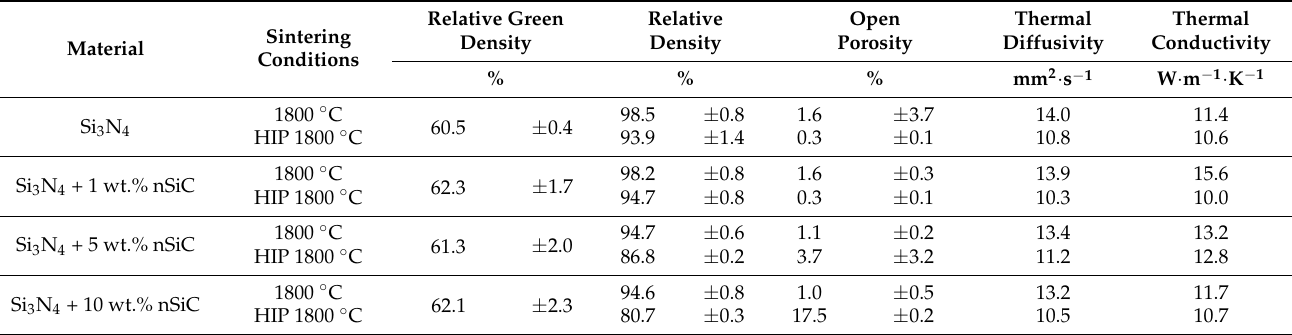
Table 2. Selected physical and thermal properties of the materials were obtained by sintering under ambient pressure at a temperature of 1800 ◦ C and in the hot isostatic press at a temperature of 1800 ◦ C.